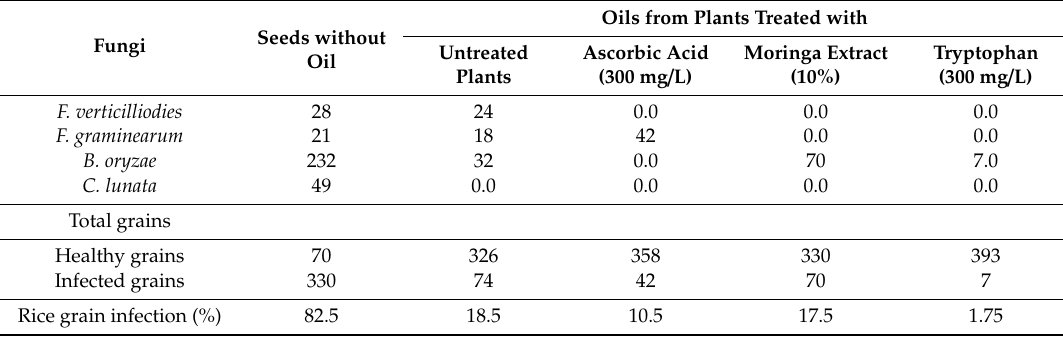
Table 8. E ff ect of treatments with selected essential oils of O. majorana on seed-born